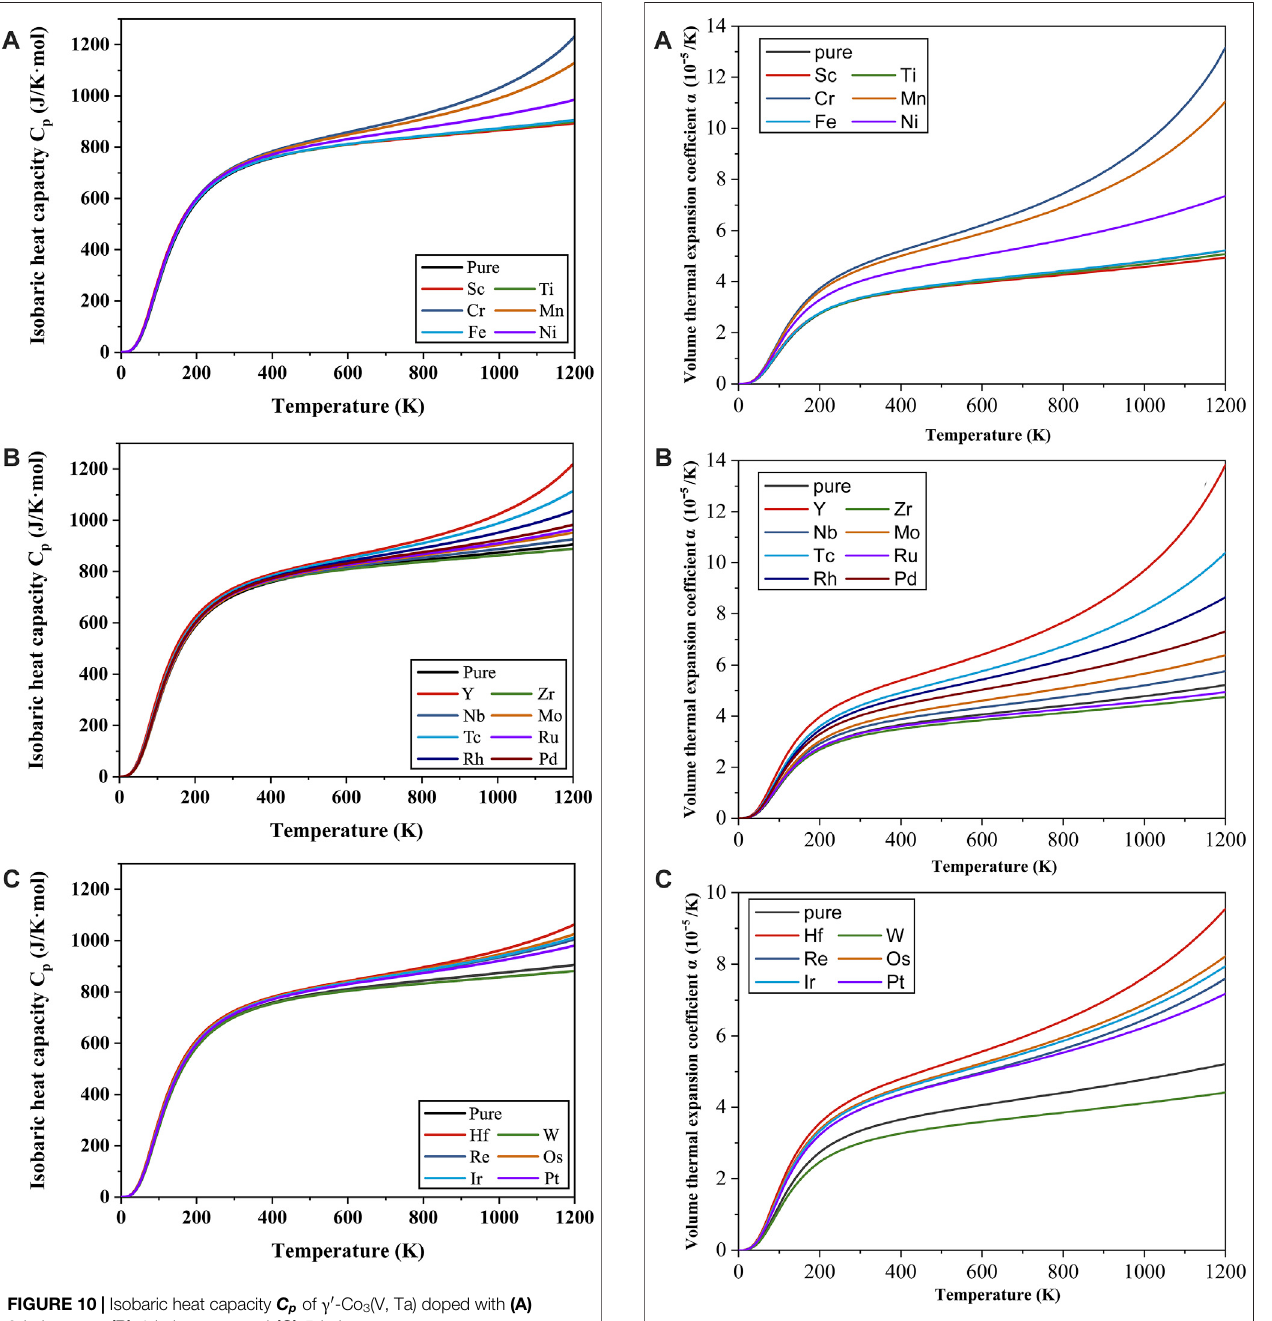
FIGURE 11 | Volume thermal expansion coef fi cient α of γ ′ -Co 3 (V, Ta) doped with (A) 3d elements, (B) 4d elements, and (C) 5d